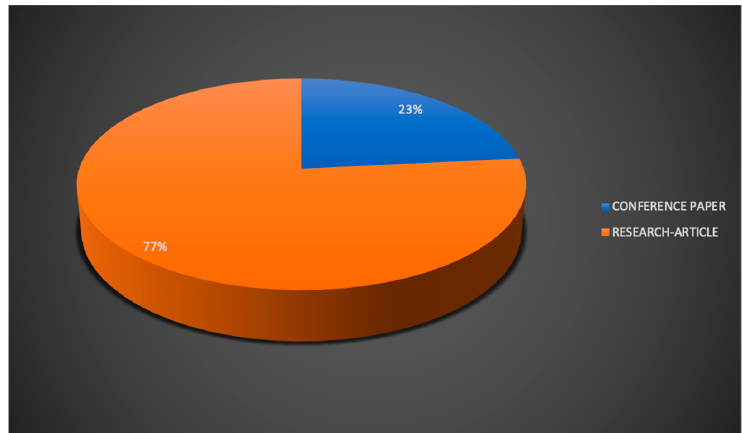
Figure 5. Reviewed publications related to HoloLens 2 research by type of publication.